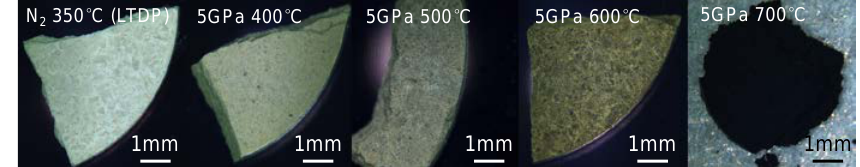
Figure 2. Optical image of LTDP and samples treated at 5 GPa and 400–700 °C.